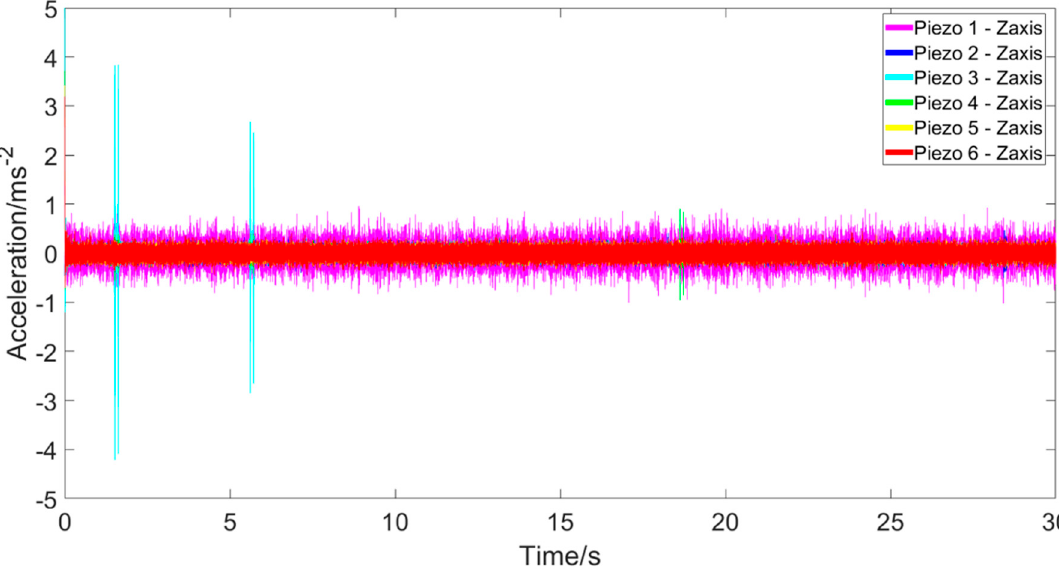
Figure 6. Live acceleration results for the z -axis for each of the six accelerometers allowing the user to immediately see any changes to the dynamics of the system.